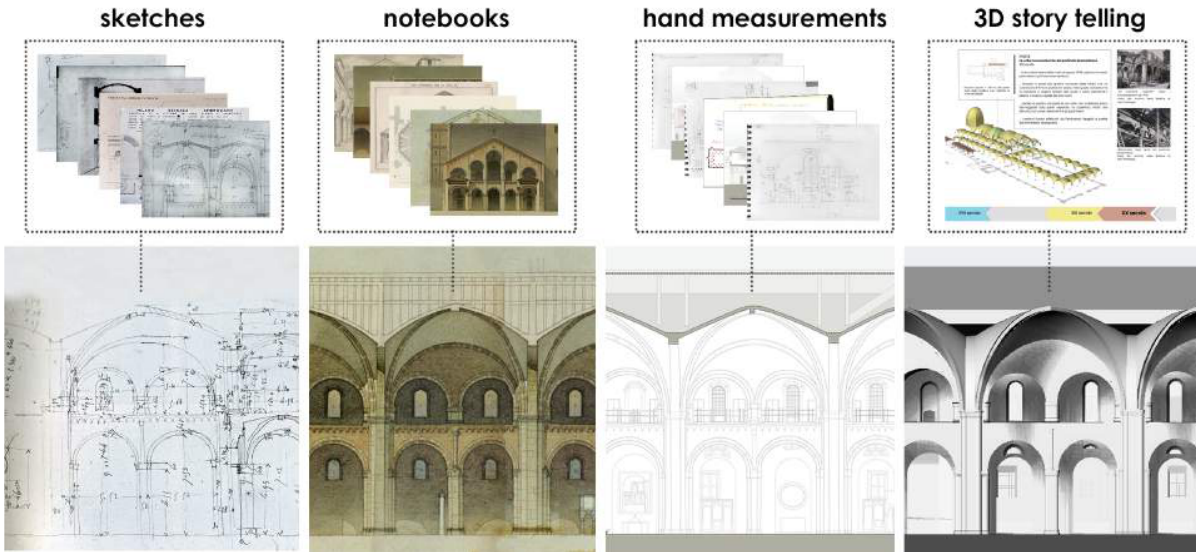
Figure 1. From traditional to virtual